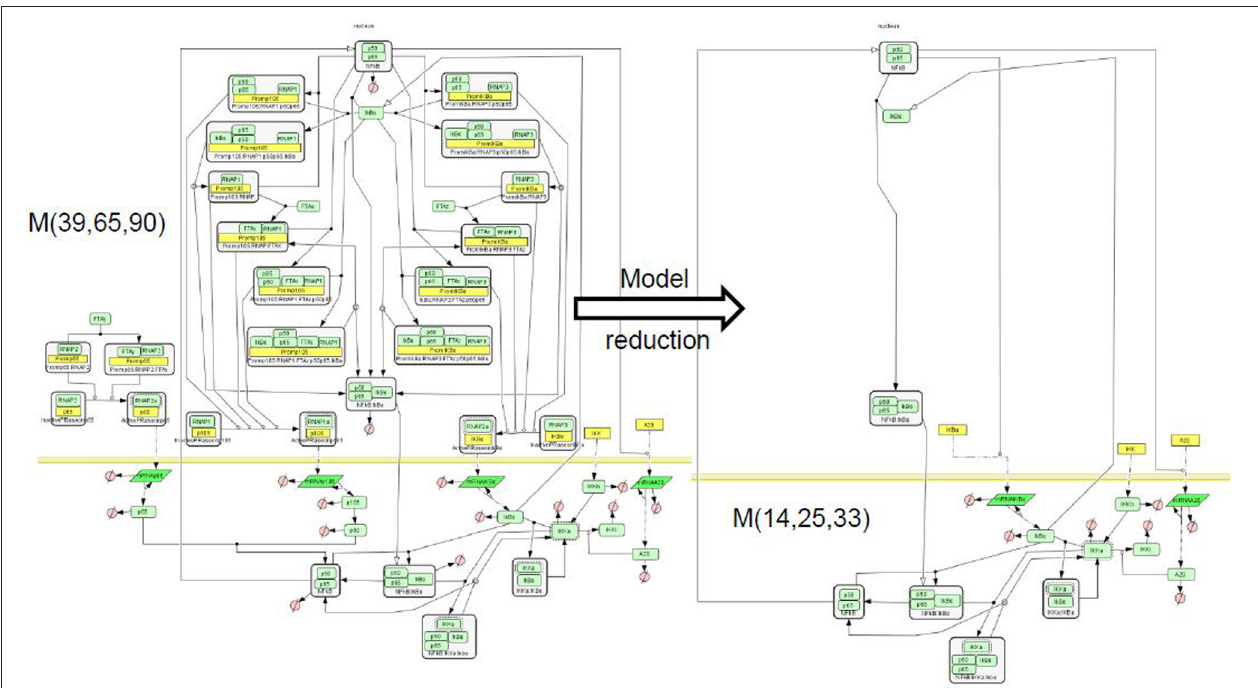
FIGURE 6 | Reduction of a NF- κ B pathway model. We considered the model of NF- κ B signaling [BIOMD0000000227in Biomodels database (Le Novère et al., 2006)], proposing separate production of the subunits p50, p65, the full combinatorics of their interactions as well as with the inhibitor I κ B, the positive self-regulation of p50, and in addition an A20 molecule whose production is enhanced upon NF- κ B stimulation, and which negatively regulates the activity of the stimulus responding kinase IKK (Radulescu et al., 2008). This model, denoted M ( 39 , 65 , 90 ) contains 39 species, 65 reactions, and 90 parameters. We have reduced it to various levels of